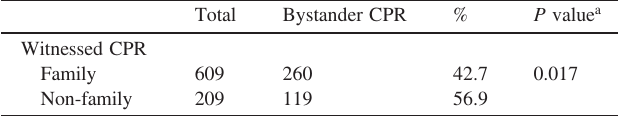
Relationship Disparity in Performing Bystander Cardiopulmonary